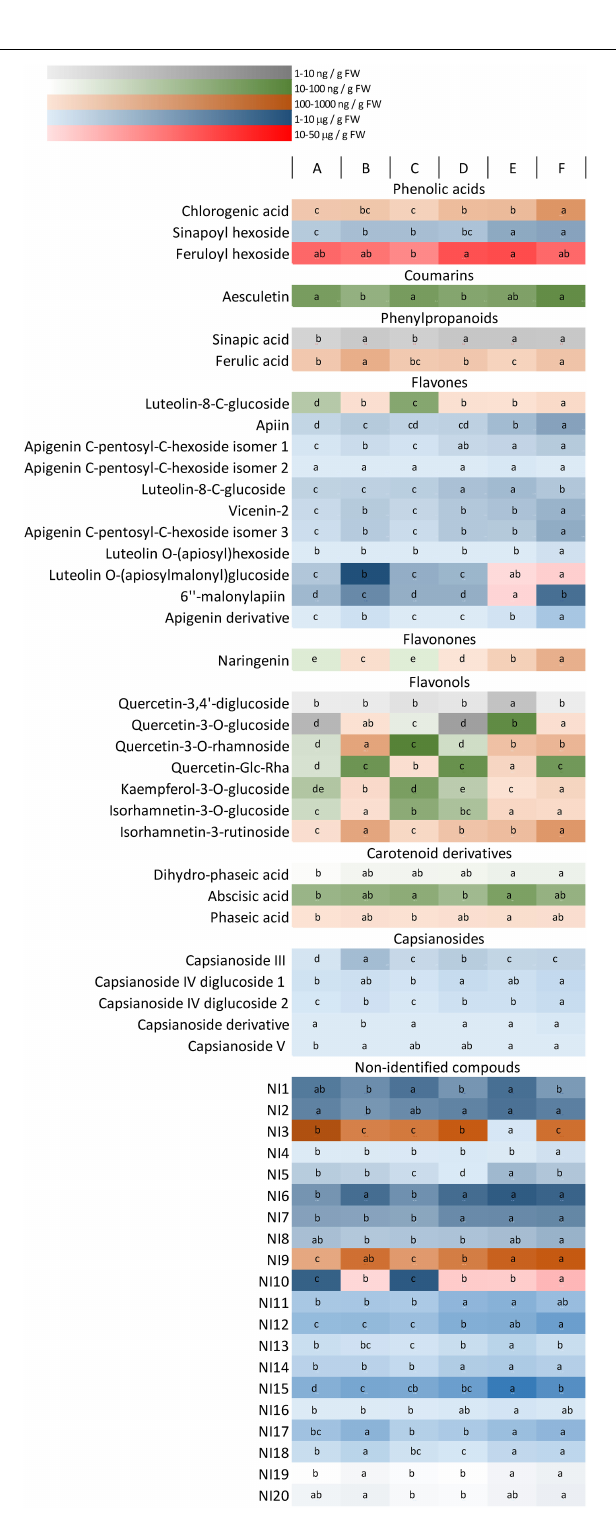
FIGURE 3 | A heat map representing the accumulation of phenolic compounds in the fruit. Different colours represent different concentration ranges. Differences between the values (within the rows) are indicated by different letters. The significance was determined at the p < 0.05 level, using